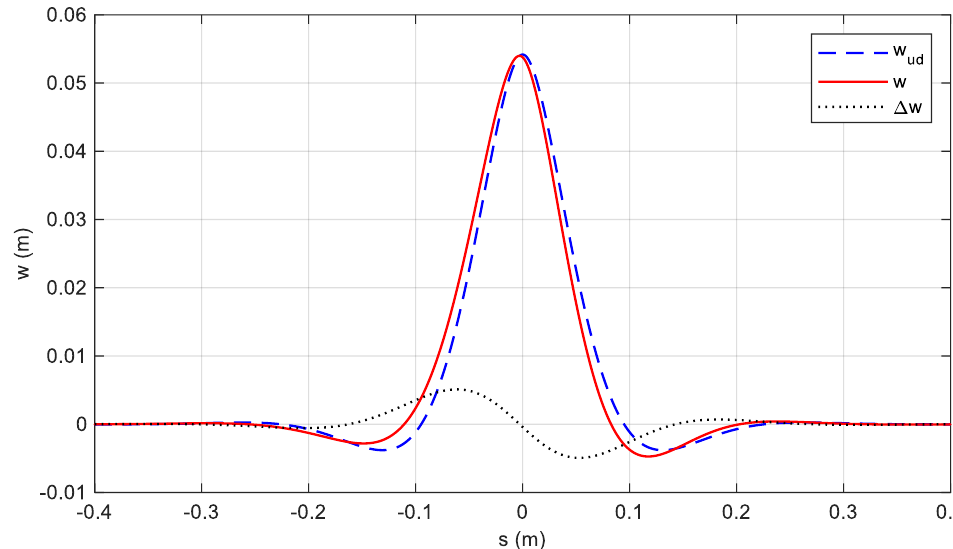
Figure 6. Undamped, damped vertical deflections and their difference in the function of the variables. Table 2. List of the constant values (see the Reference [8] for more details).